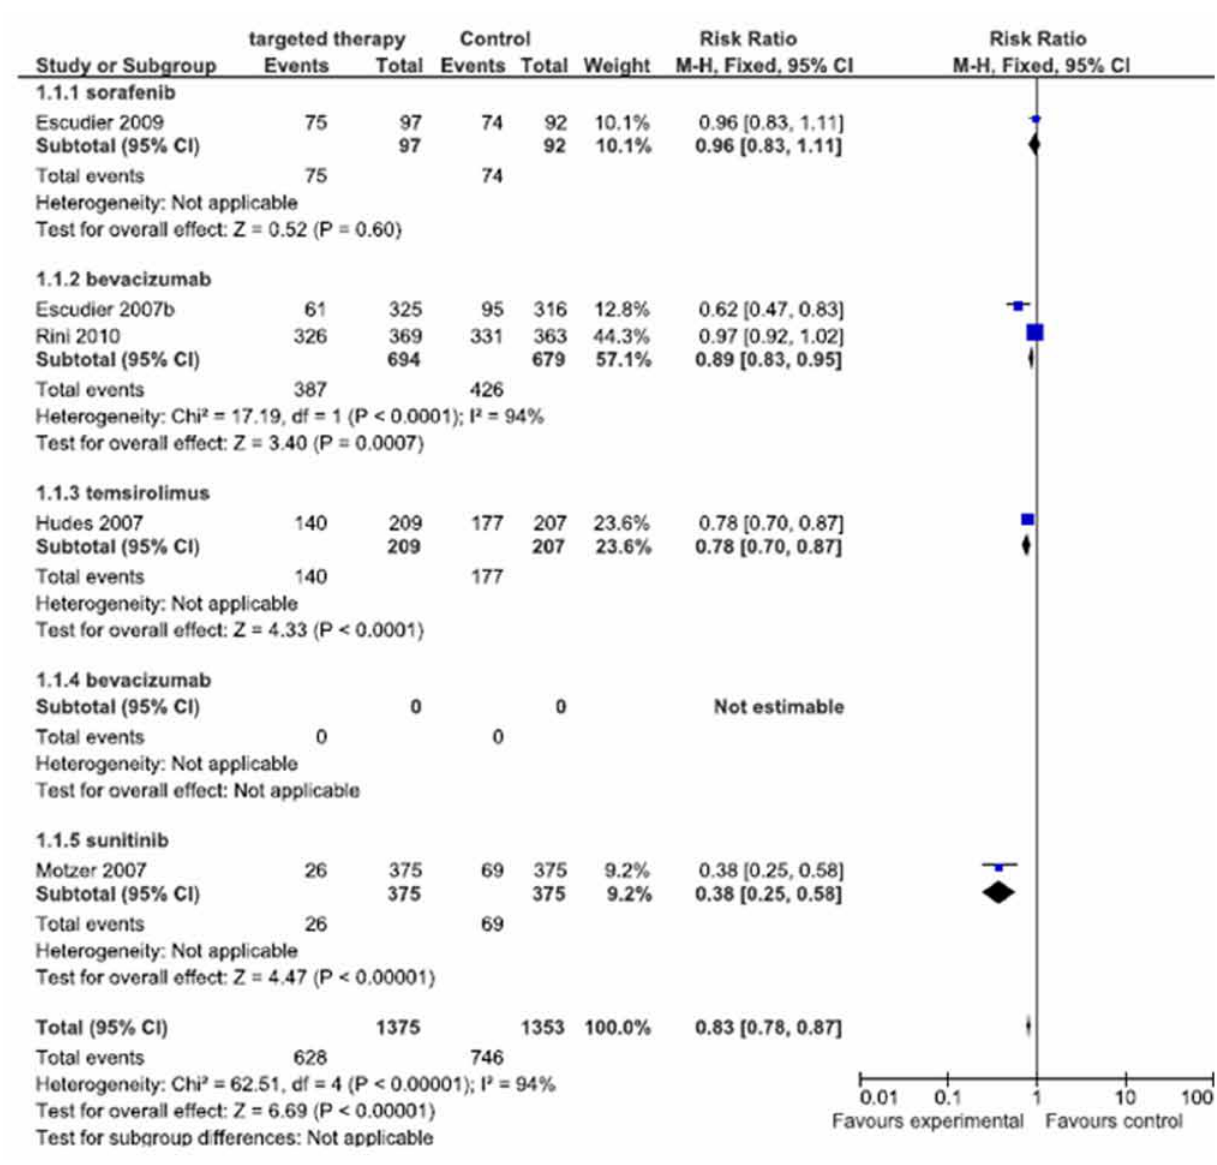
Figure 2 - Meta-analysis of free survival